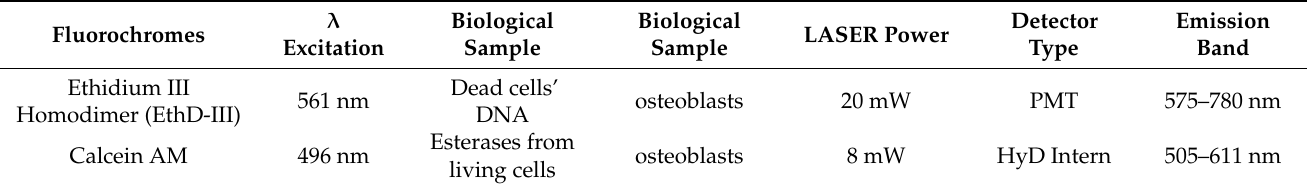
Table 2. Parameters used during microscopic acquisitions with confocal equipment for viability